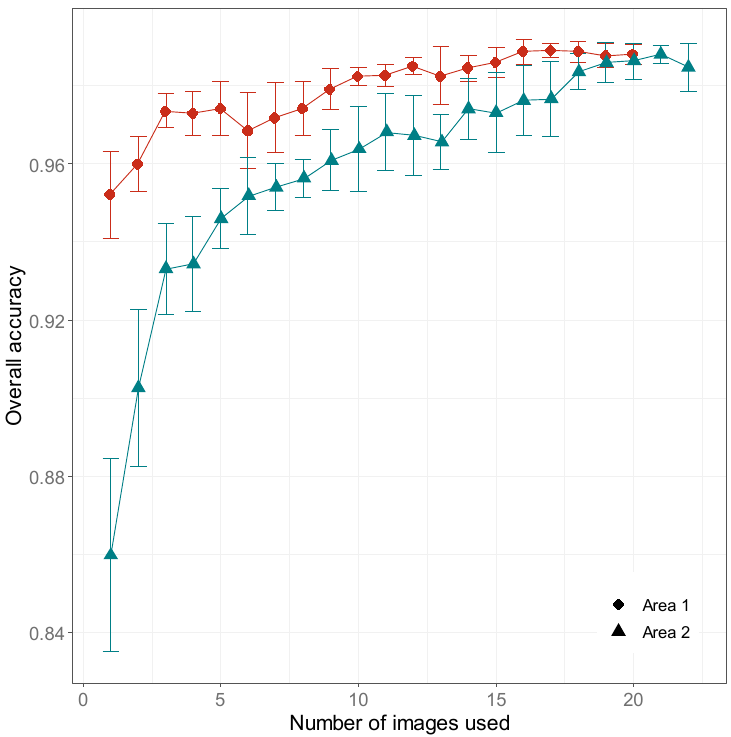
Figure 5. The mean value of the OAs with different segmentation scales for specific images in Area 1 (circles) and Area 2 (triangles). Error bars indicate the mean square error for a certain number of images used.